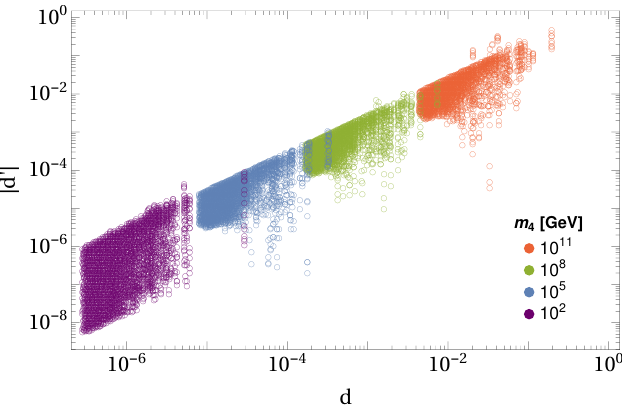
Figure 2 . (Color online) Scatter plot of the values d and j d 0 j , running over 1.000 points in the Higgs sector, (cid:12)gure 1, for speci(cid:12)c values of the heavy neutrino mass m 4 . We take (cid:21) D = 1 and sample (cid:30) 0 in the range of allowed values that give a solution to the fourth order equation (3.43). Each bunch in m 4 has more than 30.000